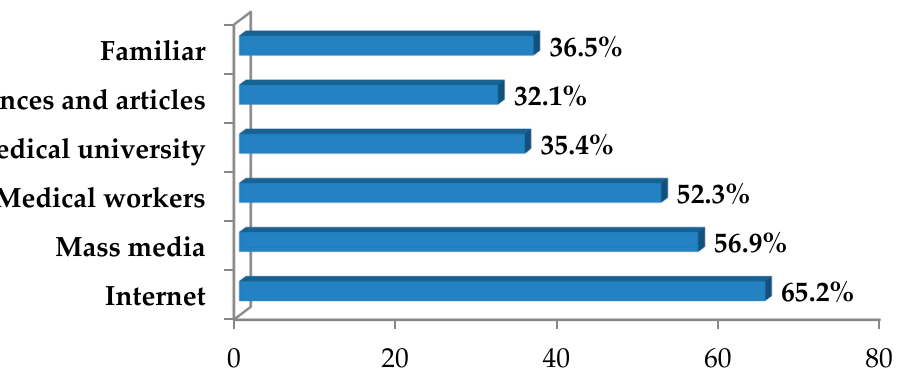
Figure 8. Key information sources of COVID-19 vaccines in medical students.